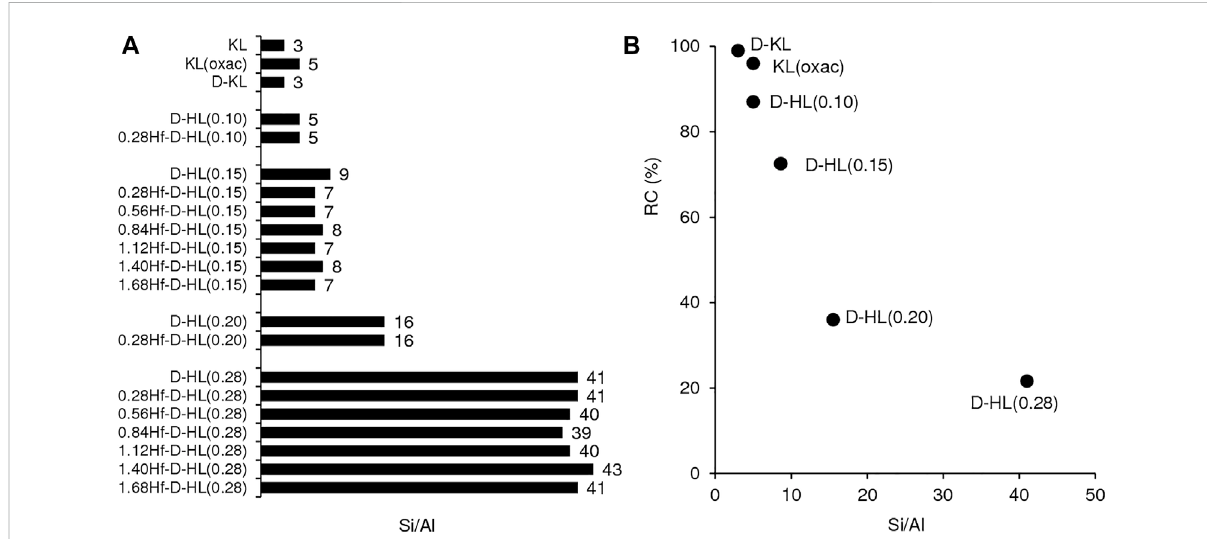
FIGURE 1 Si/Al ratio of the prepared materials (A) and relative crystallinity (RC) as a function of Si/Al (B) . The RC values are given in Table